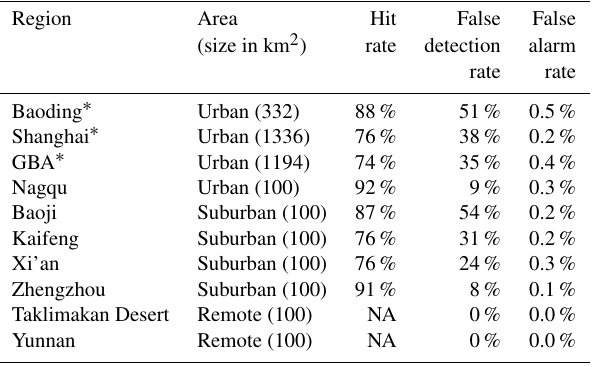
Table 2. Test results of selected locations for the blue-roof identifi- cation algorithm. NA – blue roofs are not available in the